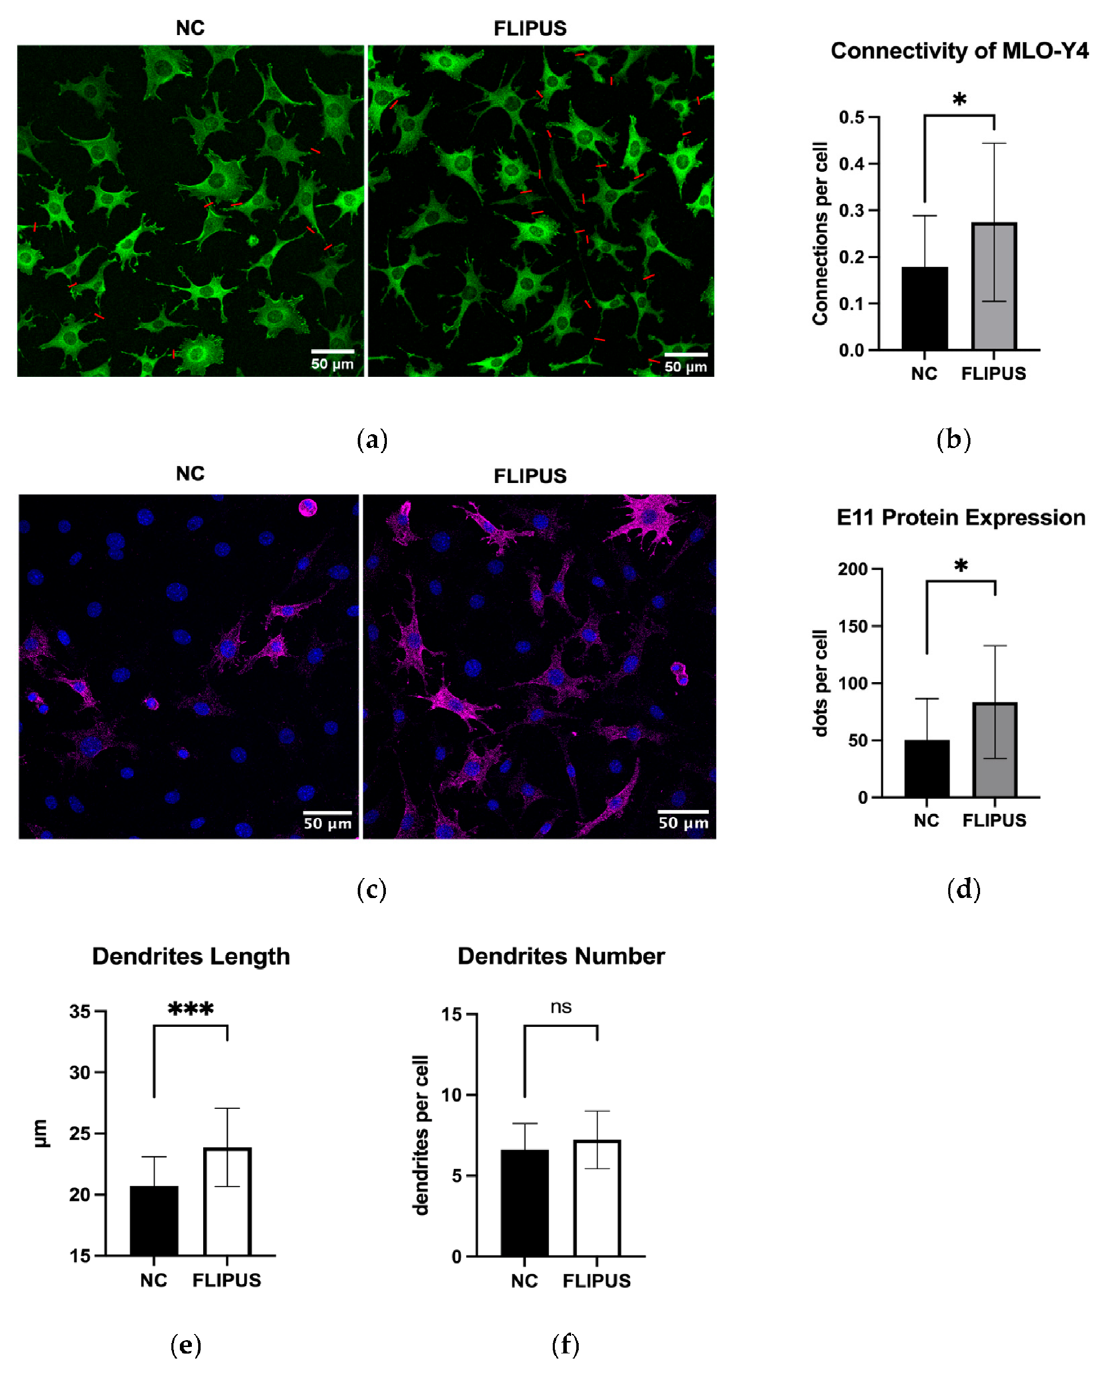
Figure 5. Ten-minute FLIPUS-stimulated starved MLO-Y4 osteocytes form extensive intercellular Figure 5. Ten - minute FLIPUS - stimulated starved MLO - Y4 osteocytes form extensive intercellular connections and exhibit enhanced expression of E11 protein. ( a ) Representative images of connections and exhibit enhanced expression of E11 protein . ( a ) Representative images of vinculin - stained cells with red lines showing formed cell – cell connections; ( b ) Quantification results of the connections made per cell; ( c ) Representative images of the E11 - stained cells; ( d ) Quantitative results